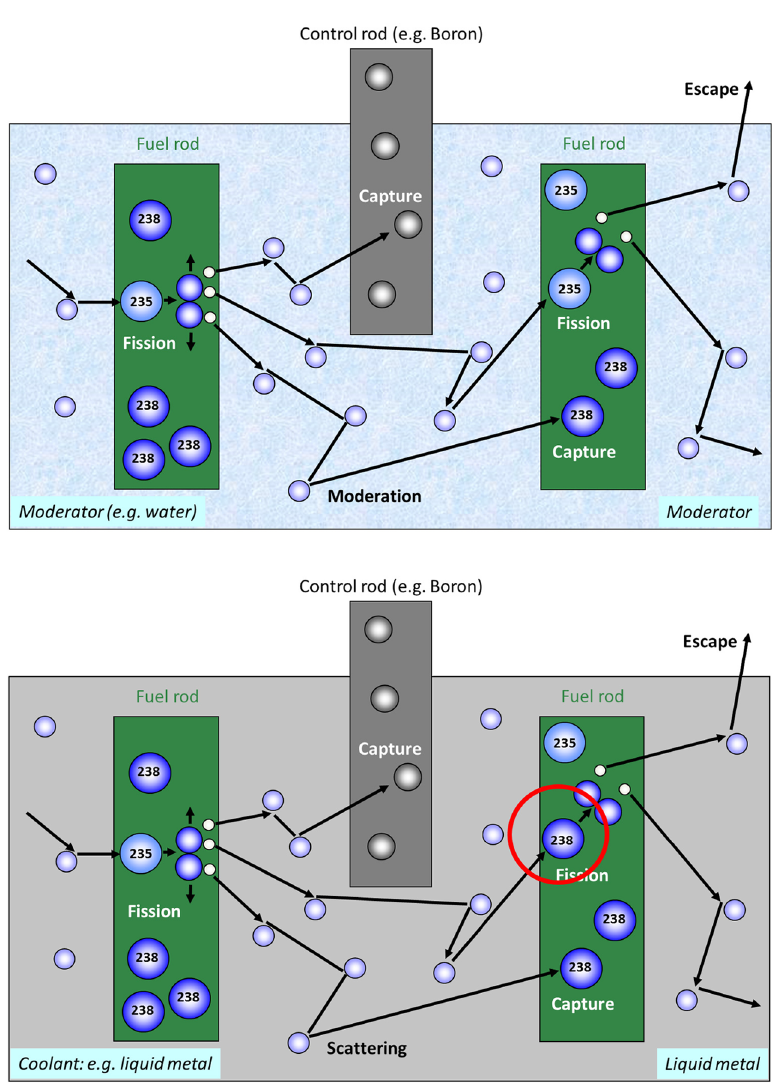
Fig. 5. – Conceptual schemes of thermal (top) and fast reactor (bottom).